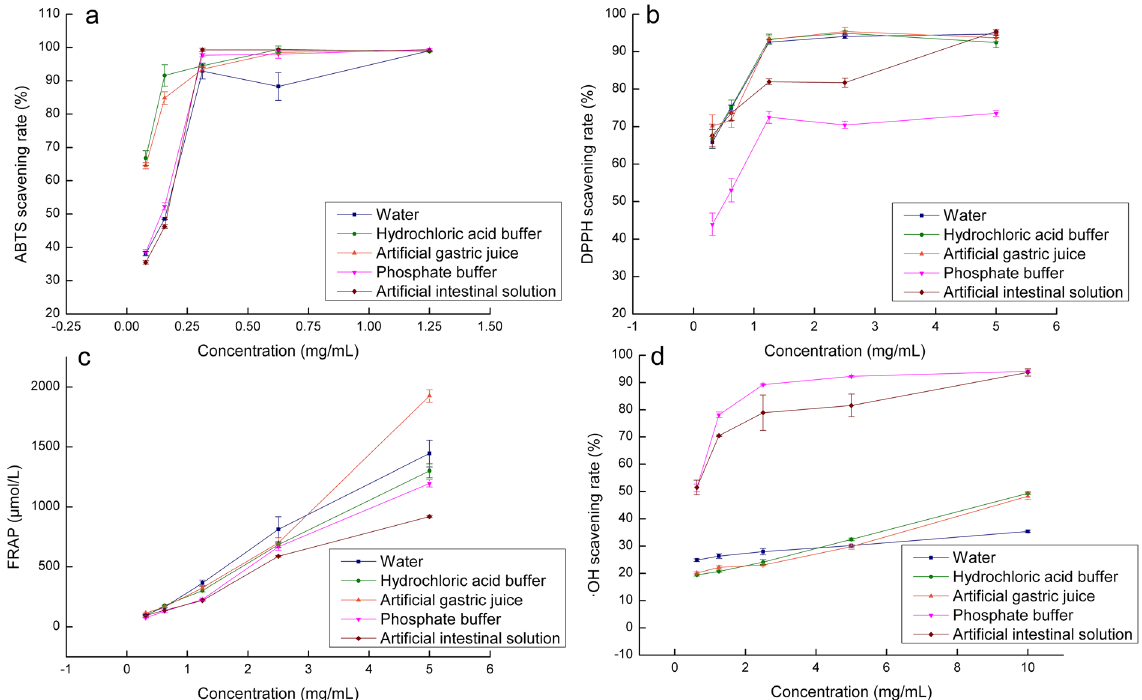
Fig. 5 Antioxidant capacity of the secondary residues of Turkish Gall by five treatment methods. ( a ABTS radicals scavenging capability; b DPPH radicals scavenging capability; c Ferric ion reducing antioxidant power; d OH radical scavenging capacity)